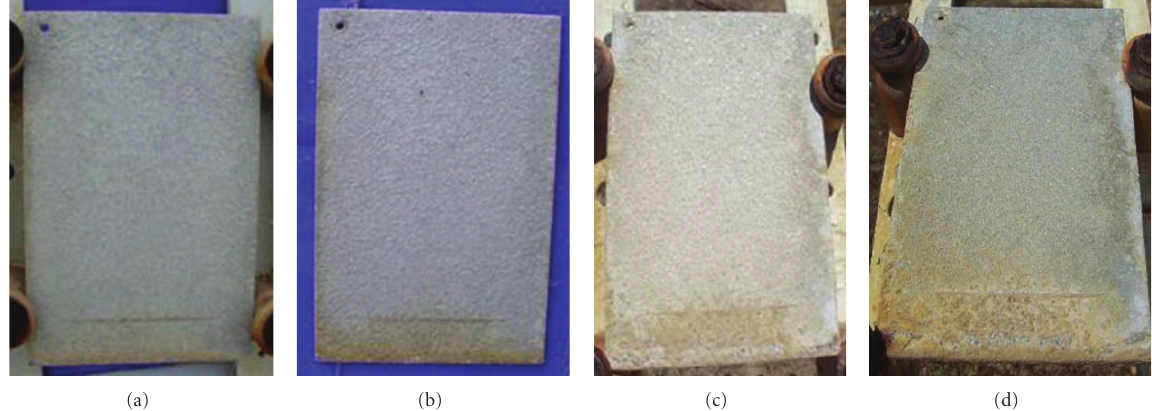
Figure 2: Thermal-sprayed coating of Zn/Al by the flame process (470 μ m). (a) 12 months of exposure. (b) 24 months of exposure. (c) 36 months of exposure. (d) 48 months of exposure.